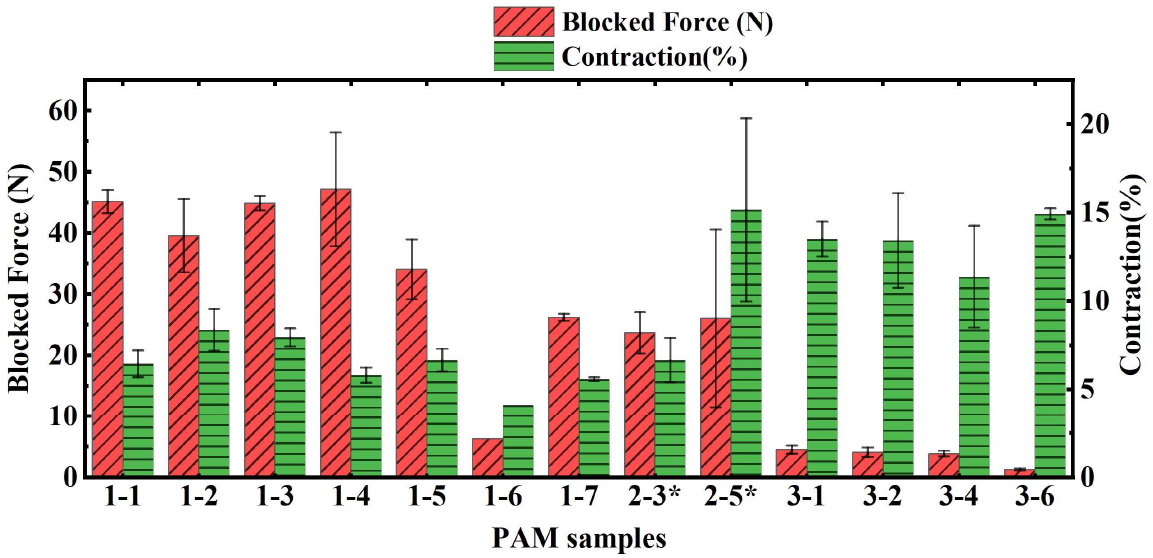
Figure 7. Blocking force and free contraction of different PAM samples at 450 kPa. * PAM 2-3 and 2-5 were actuated at 300 kPa and 400 kPa, respectively, since they did not survive the higher pres- sure.